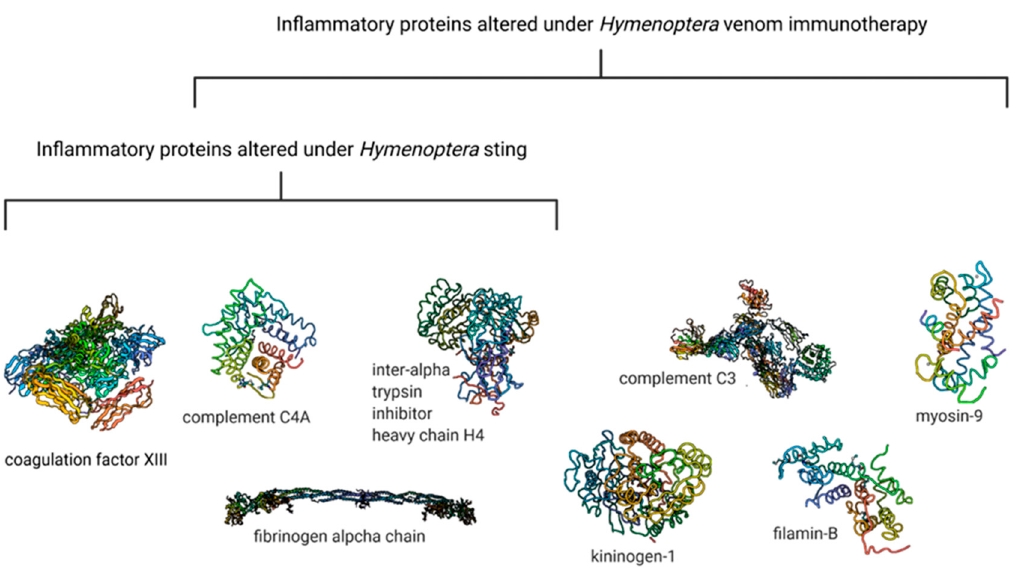
Figure 5. Proteins changed under Hymenoptera insect sting and VIT (based on MALDI-TOF